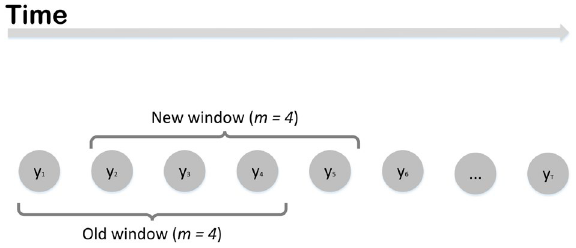
y , y , . . . , y of epidemic data with an example rolling window of size m = 4 . Rolling 1 2 T (cid:31) (cid:30)